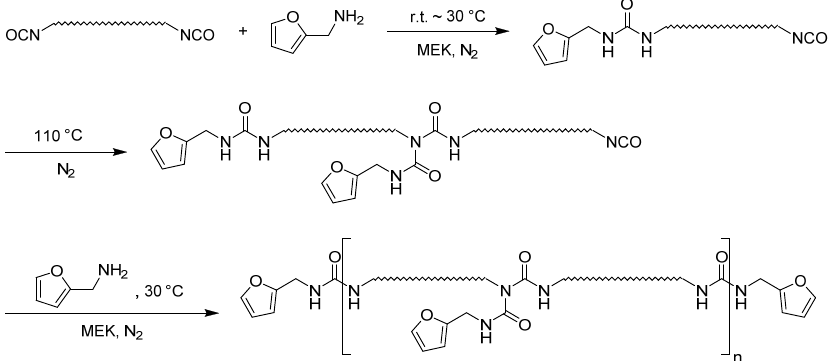
Figure 1. Reaction scheme for the preparation of the furan-functionalized prepolymer.